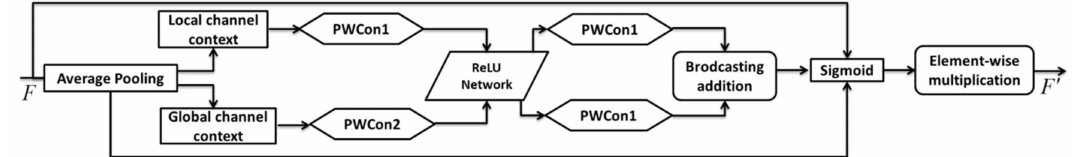
Figure 11. Architecture of the MAFFN